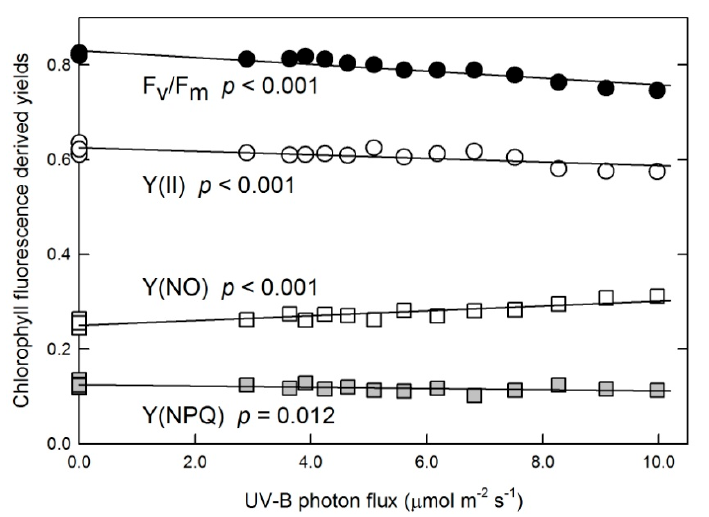
Figure 2. Changes in photochemical yields F v /F m and Y(II), regulated non-photochemical quenching Y(NPQ), and non-regulated non-photochemical quenching Y(NO) in tobacco leaves exposed to various UV-B photon fluxes. Symbols represent data of individual leaves and solid lines show linear fits characterized by corresponding p -values.